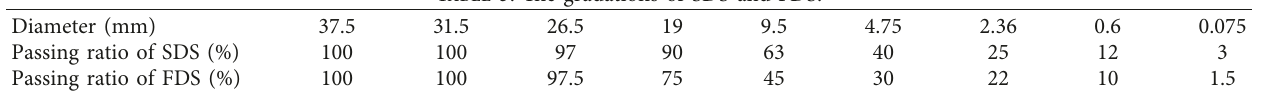
Figure 6: Gradation structure models: (a) structure model of FDS and (b) structure model of SDS. Table 5: The gradations of SDS and